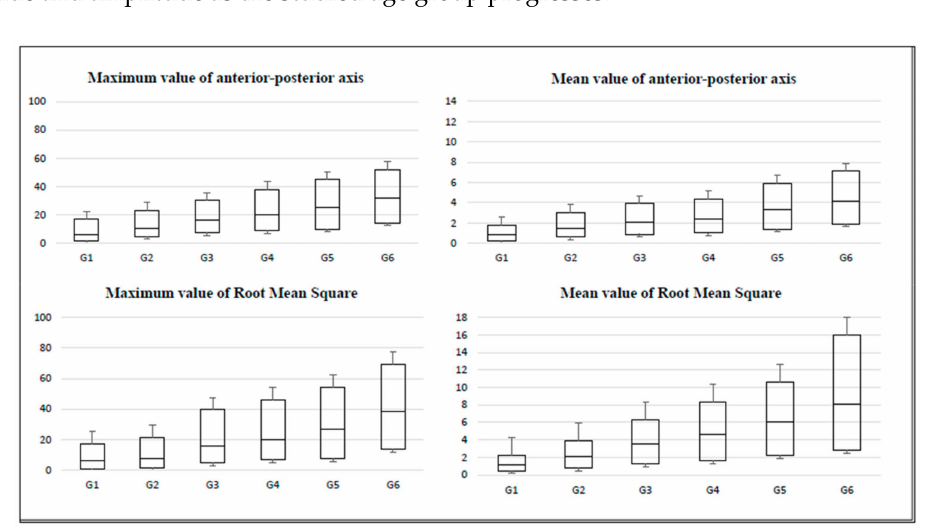
Figure 2. Box charts for the monopodal balance test with open eyes by age group.